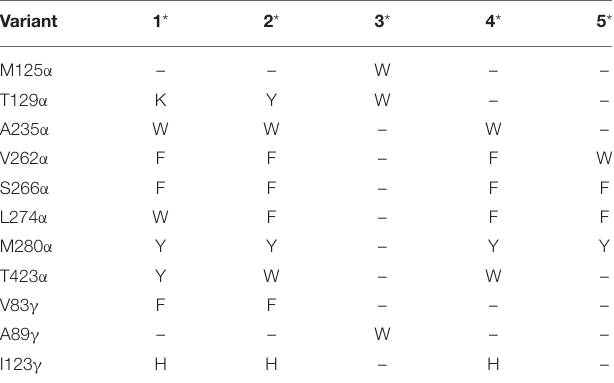
TABLE 3 | Top five variants for simultaneously improving the rate of product release and stabilizing the transition state.